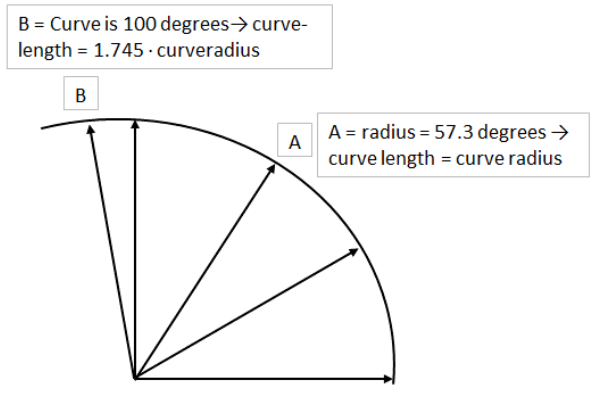
Figure 2 Tracing out a curve with constant radius and increasing deflection